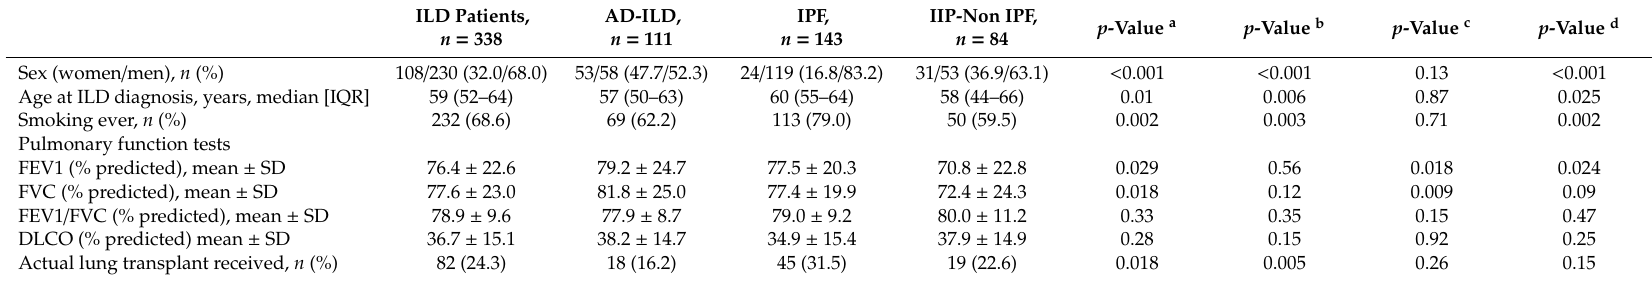
Table 1. Demographic and clinical features of 338 patients with ILD included in this